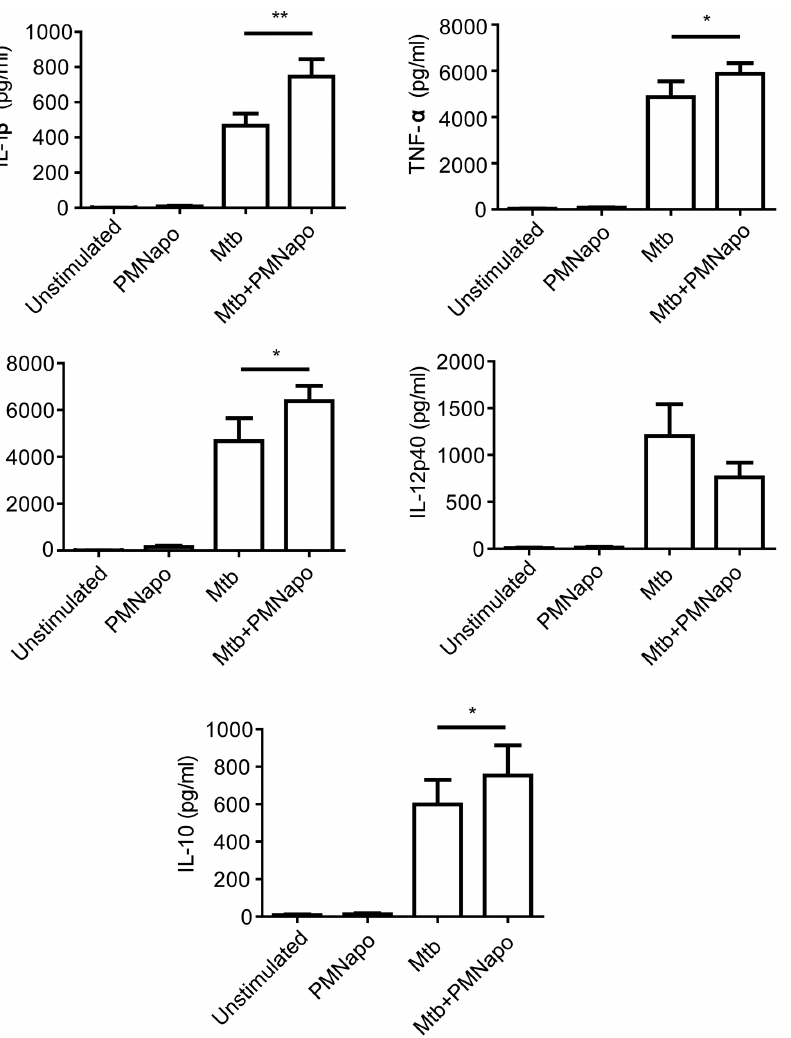
Figure 2. Apoptotic neutrophils augment the inflammatory response of hMDMs to Mtb. hMDMs were stimulated with c -irr Mtb at a ratio of 5:1 (Mtb) with or without PMNapo at a ratio of 2:1 ( + PMNapo) for one hour, where after non-ingested bacteria and cells were removed and the hMDMs were re-cultured with the supernatants for 18 h. Cytokine (TNF a , IL-1 b , IL-6, IL-10 and IL-12p40) levels were measured by cytometric bead array and data are expressed as mean cytokine released + SEM (n=8). Differences between groups are shown as * (p , 0.05) or ** (p , 0.01) or *** (p , 0.001).